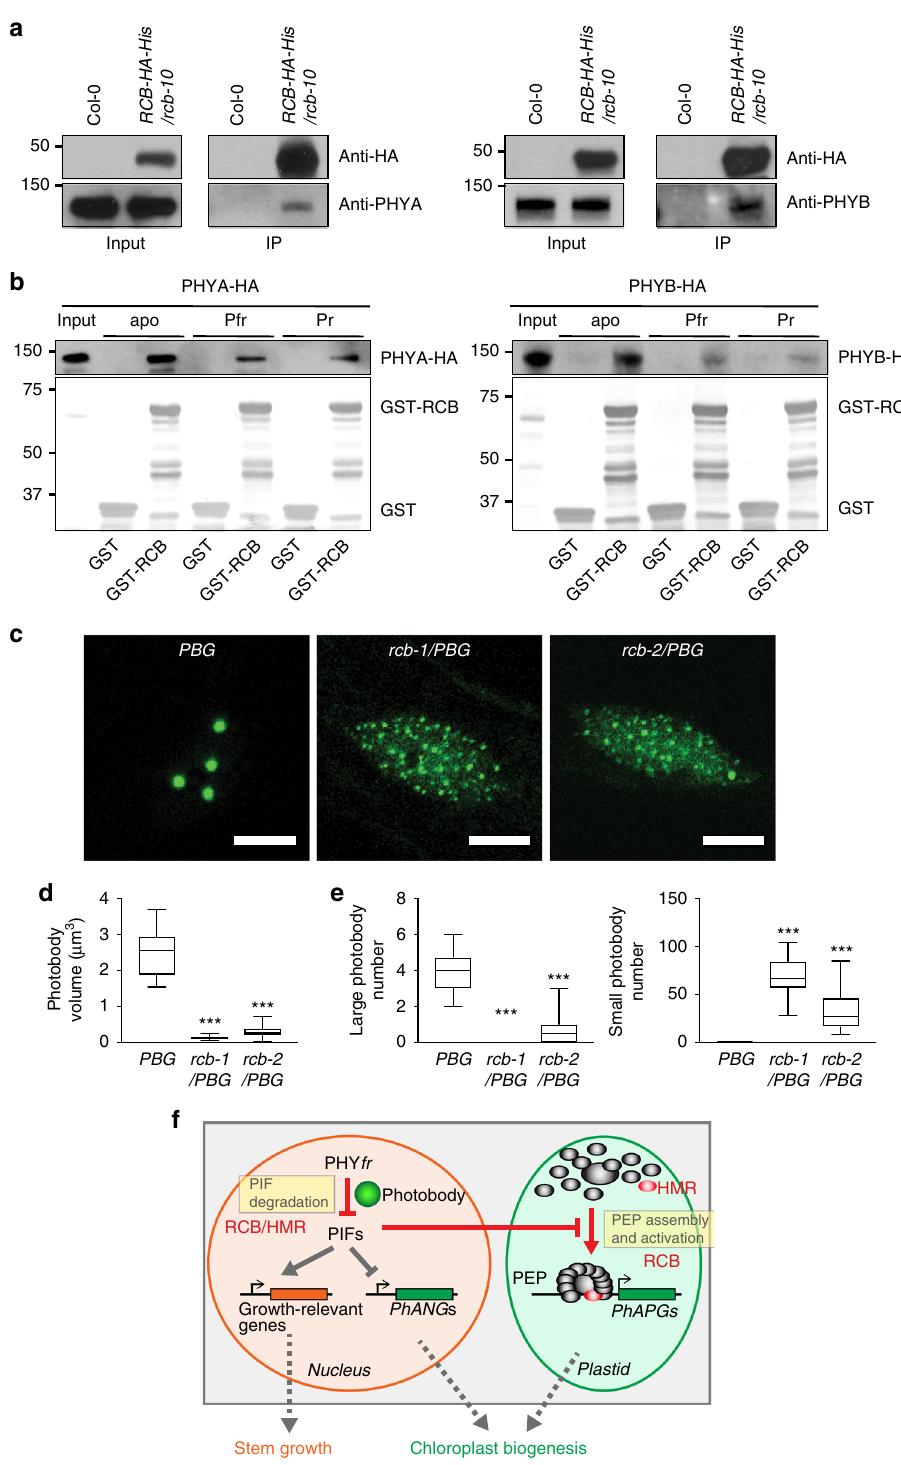
(Fig. 4d), failed to stimulate PEP assembly and PhAPG expression in the light (Fig. 2g, f). Both PEP assembly and PhAPG expression were de-repressed in the pifq mutant in the dark (Fig. 5) as well as in rcb-10/pifq in the light (Fig. 6c, d), indicating that PIFs are also nuclear repressors of PhAPG expression. It is worth noting that it remains unclear whether all PIFs are required for repressing PhAPG expression, which requires further genetic analysis of the